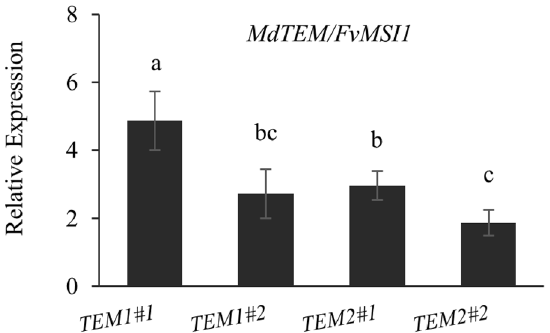
Figure 6. Relative expression of MdTEM1 and MdTEM2 genes in overexpressing 35S::MdTEM1 and 35S::MdTEM2 lines. RNA was measured using NanoDrop and 1 µg of RNA was used for each sample. Samples were collected at ZT 8 from fully expanded young leaves of plants in the growth chamber at 25 °C under 16/8 h. light/dark photoperiod. Error bars indicate standard errors. Means were compared by LSD test and different letters show a significant difference at p ≤ 0.05.